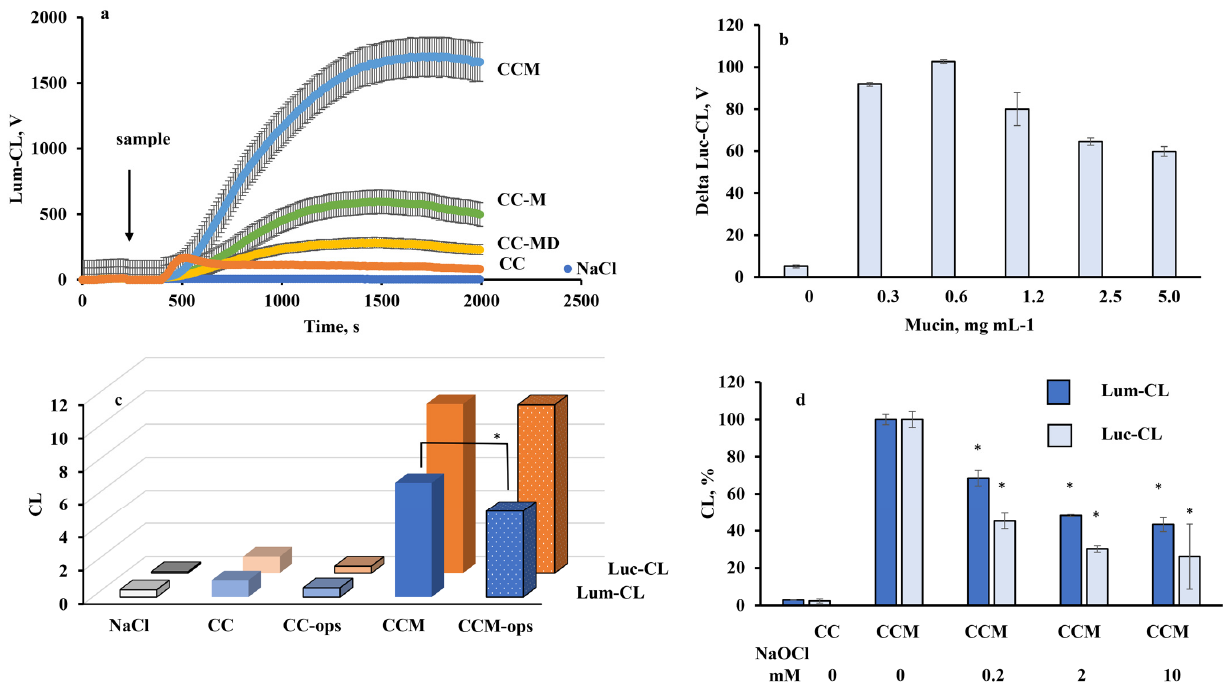
Figure 3. Chemiluminescent response of activated neutrophils: ( a ) Time-course of Lum-CL re- sponse to CC, CC-MD, CC-M (CC coated with mucin by adsorption), and CCM (prepared by CC co-precipitation with mucin). The arrow indicates the time-point of sample addition. Sample concen- tration was 1 mg mL − 1 ; neutrophil concentration was 0.6 × 10 6 mL − 1 . ( b ) Effects of concentration of mucin in solution for CC coating on Luc-CL amplitude. ( c ) Effects of opsonization of micropar- ticles with autologous serum on Luc-CL and Lum-CL peak values normalized by response to CC microparticles (* p < 0.05 vs. CCM). ( d ) Effects of concentration of NaOCl at incubation with CCM on subsequent activation of neutrophils assessed as Luc-CL and Lum-CL peak values. Data are represented as % to samples with untreated CCM (* p < 0.05 vs. untreated CCM). Each value was measured in triplicate. Concentration of microparticles was 1 mg mL − 1